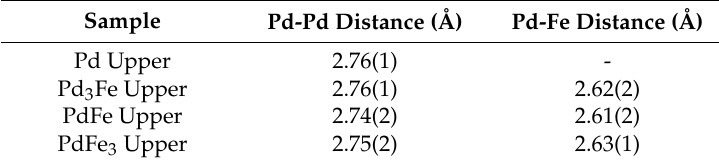
Figure 10. Fourier transforms of the Pd K-edge EXAFS oscillation function k 3 χ (k). No phase shift corrections are made. The first sets of nearest peaks represent the Pd-Fe and Pd-Pd distances. Table 2. Local bonding distances (Å) in Pd-Fe alloy nanoparticles determined by EXAFS.